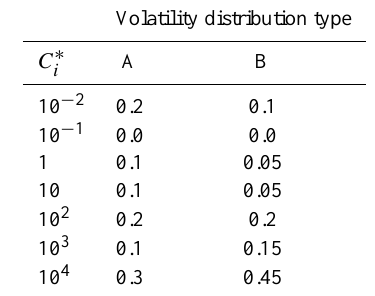
Table 1. Two types of volatility distributions ( f i ) used in this study for specifying emissions of POA species from fires. The distribu- tions are based on the data by May et al. (2013) and were used together with the recommended values of the accommodation